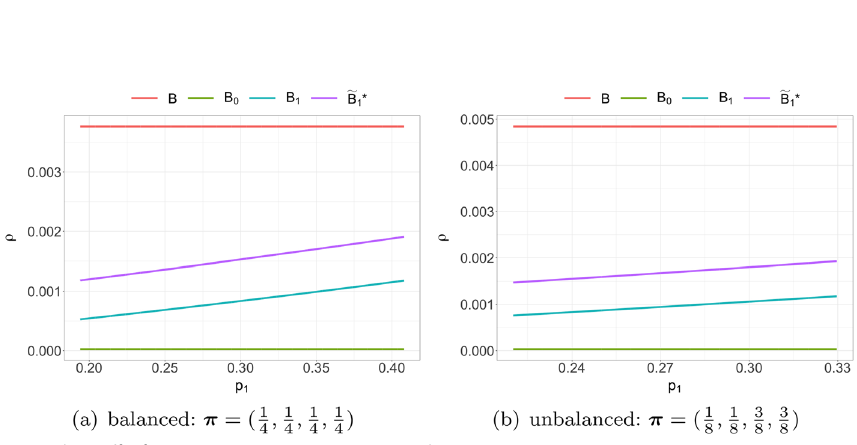
Fig. 3 Chernoff information ρ as in Eq. (10) corresponding to B as in Eq. (14), B 0 as in Eq. (13), B 1 as in Eq. (15),